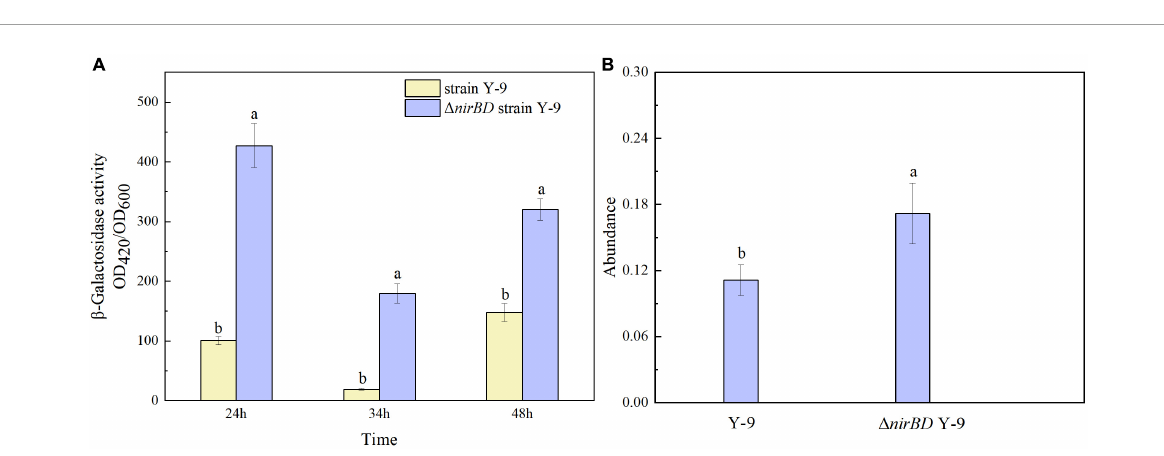
FIGURE3 GlnA expression in strain Y-9 and (cid:77) nirBD strain Y-9. (A) β -Galactosidase activity. (B) Relative expression abundance of glnA . The different lowercase letters above the bars indicate significant differences among treatments ( P <